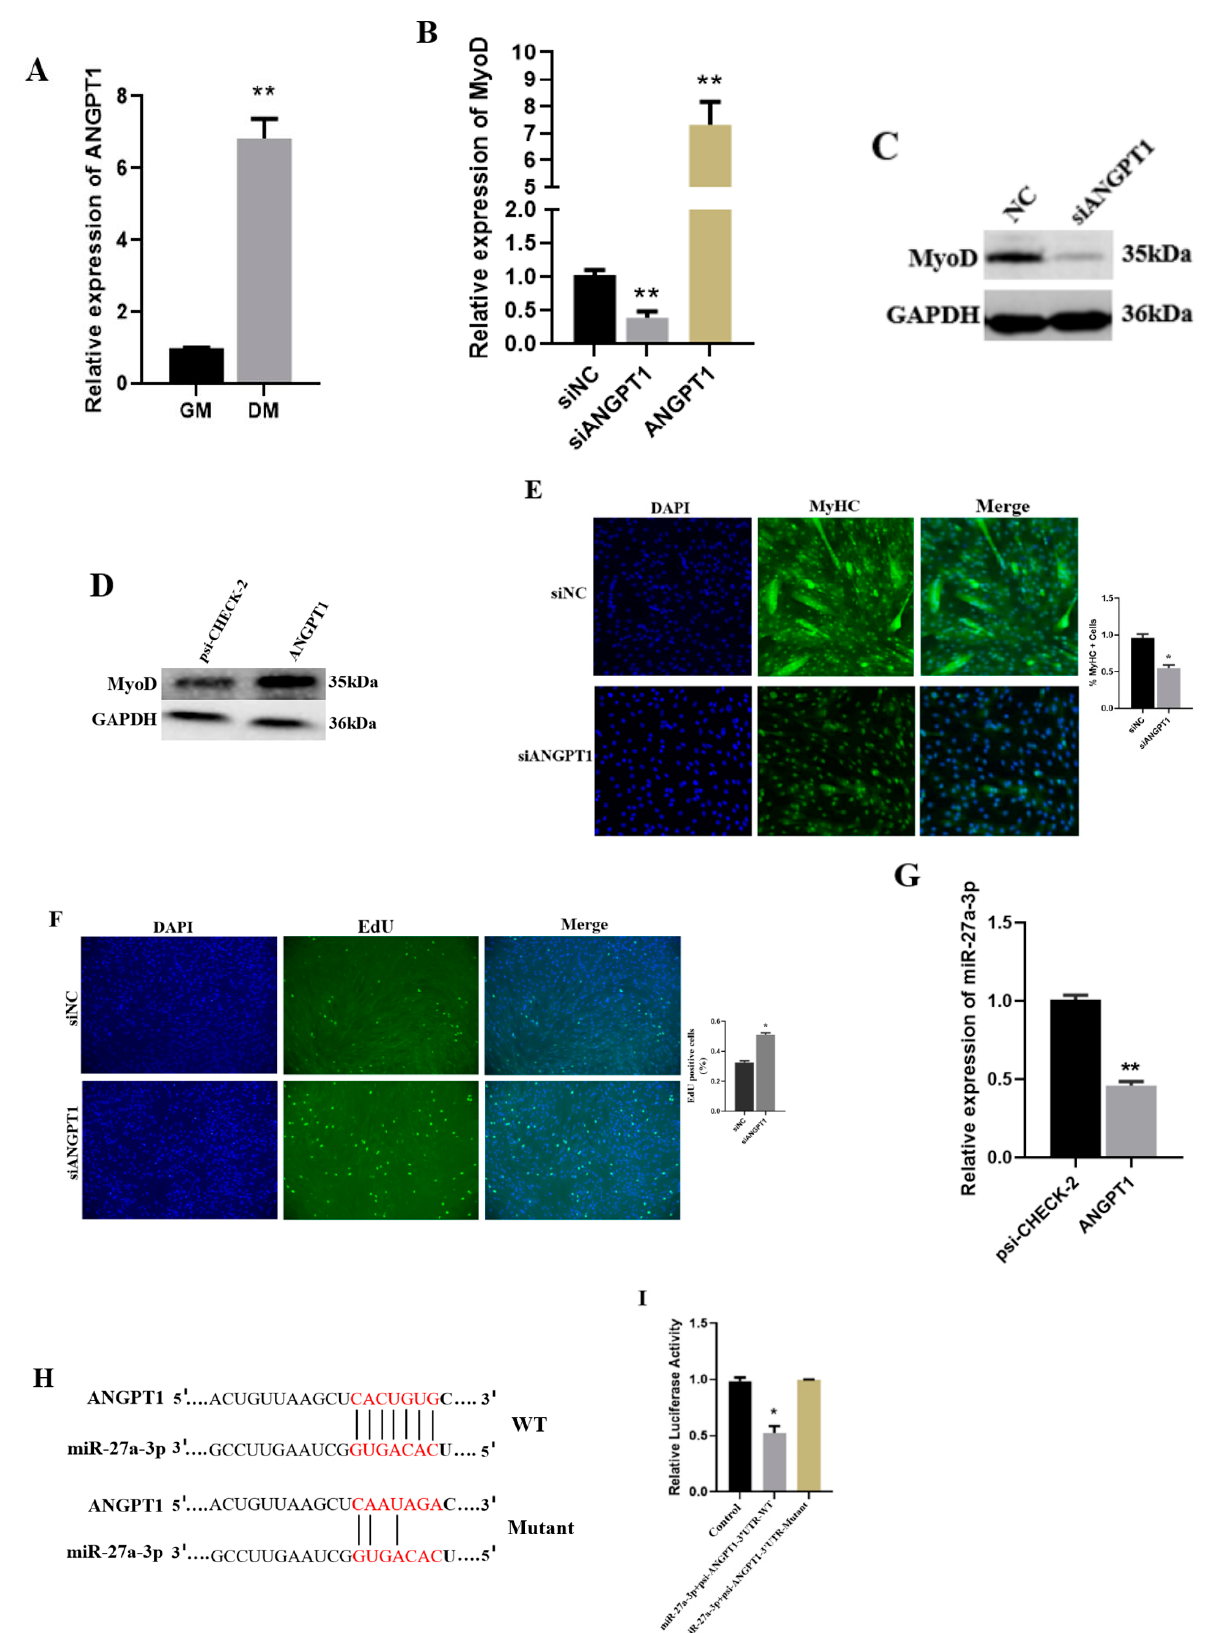
Figure 4. The function of ANGPT1 and its regulatory role in SMSCs. ( A ) qRT-PCR analysis to deter- mine the expression level of ANGTP1 in the GM and DM of SMSCs. ( B ) qRT-PCR analysis of